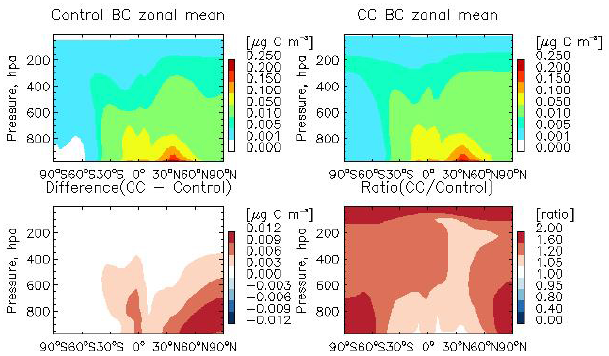
Fig. 5a. Model simulated annual mean surface BC concentrations from the sensitivity run versus the control run. (Upper left) BC con- centrations from the control run; (upper right) BC concentrations from the sensitivity run using the condensation-coagulation aging scheme; (lower left) differences between the sensitivity run and con- trol run results; (lower right) ratio between sensitivity run and con- trol run results.